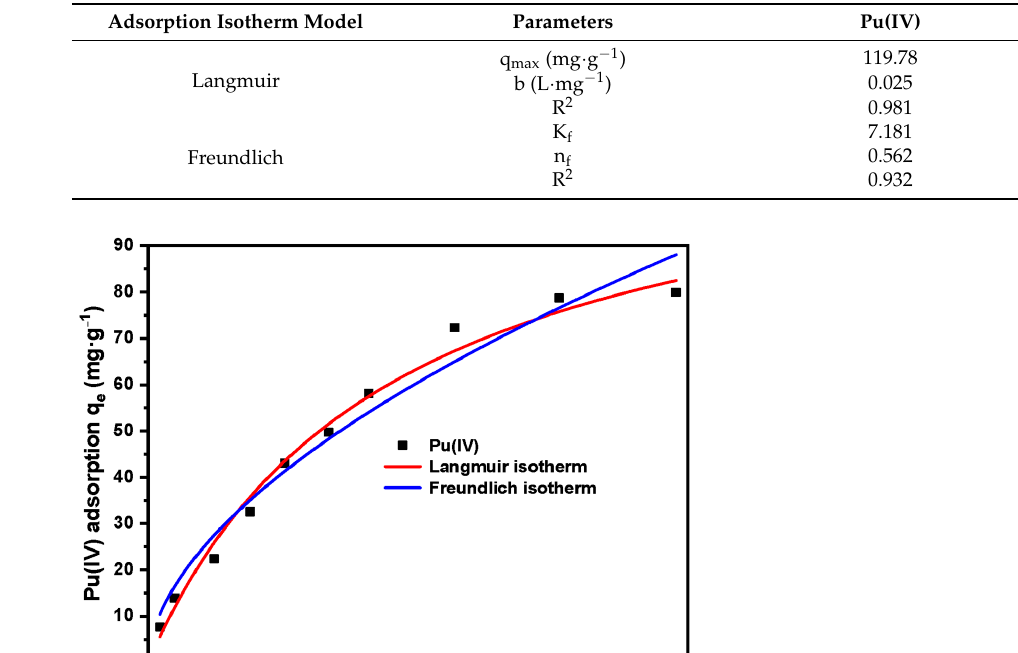
Table 5. Langmuir and Freundlich adsorption isotherm parameters for Pu(IV) on SG-VTS-VPQ.